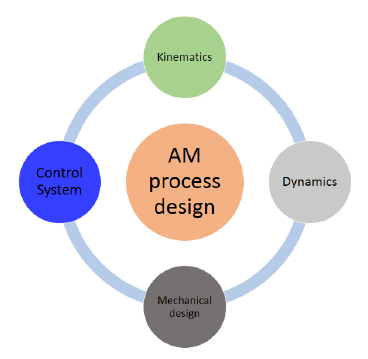
Figure 3. Design